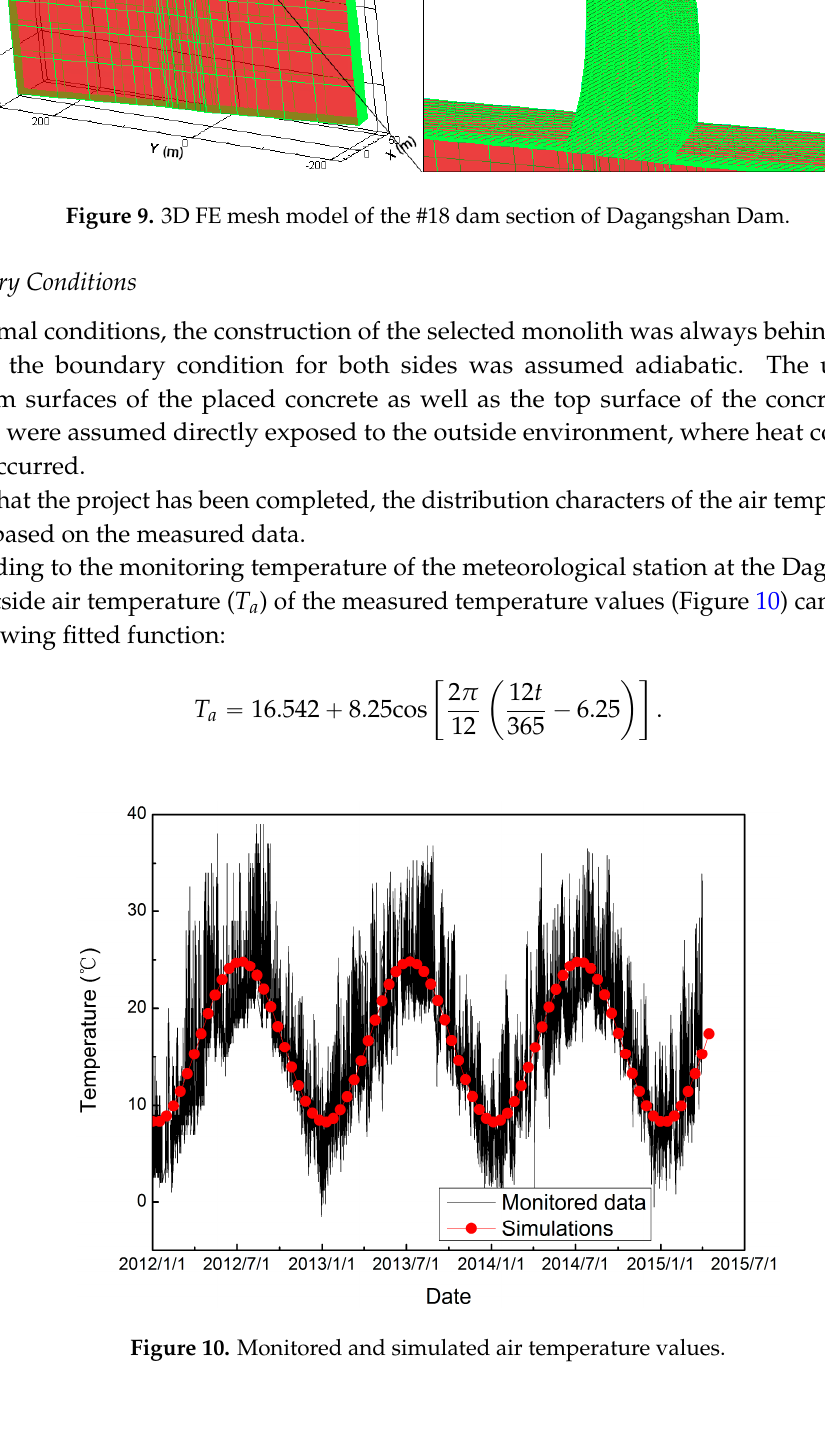
Figure 10. Monitored and simulated air temperature values.